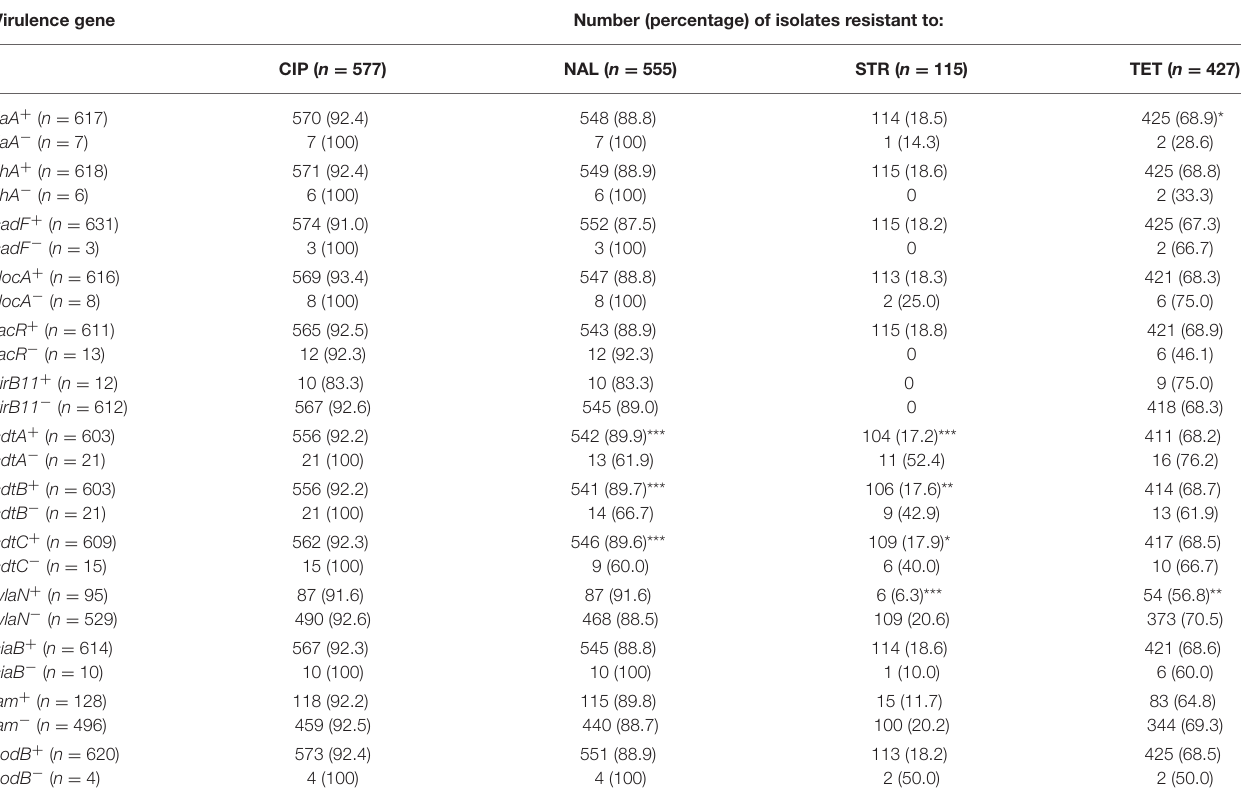
TABLE 4 | Relationship between virulence genes and antimicrobial resistance patterns in all C. jejuni tested. Virulence gene Number (percentage) of isolates resistant